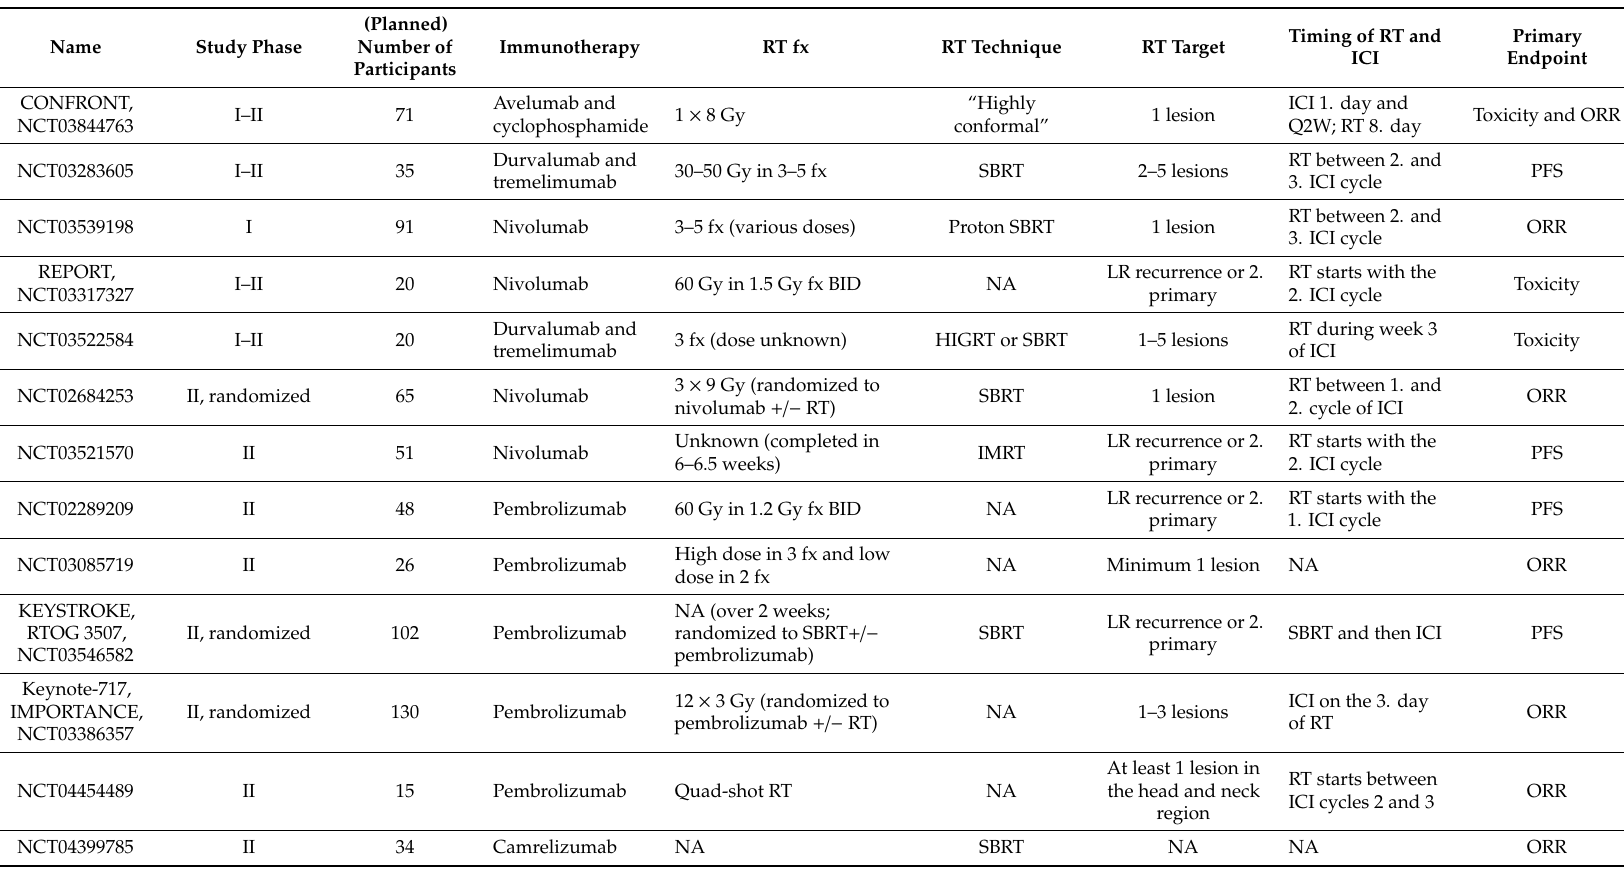
Table 1. Ongoing clinical trials incorporating radiotherapy and immunotherapy in recurrent or metastatic head and neck squamous cell